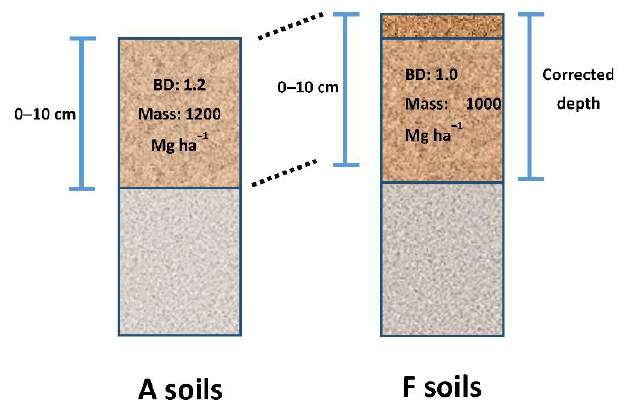
Figure 2. Changes in soil horizonation, bulk density (BD), and mass after forest regeneration of agricultural soils (A soils). The additions of fresh soil organic matter from litter and dead roots in the forest regenerated soils (F soils) caused decreases in the changes in both bulk density and soil mass below a certain depth. The corrected soil organic carbon (SOC) stocks in F soils were calculated as follows: SOC stocks (corrected) = SOC stocks (uncorrected) × (BD A /BD F ). BD A and BD F are the bulk density for A and F soils, respectively.